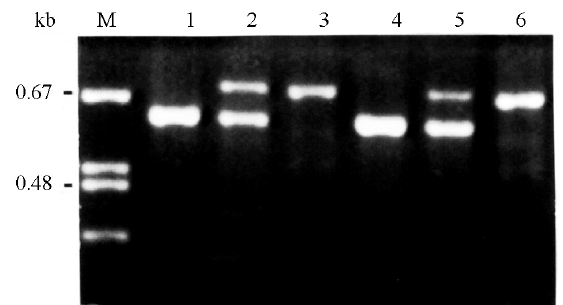
Figure 4 - Gel electrophoresis of the amplified rDNA internal transcribed sequence (ITS) region of the Eucalyptus grandis - Pisolithus tinctorius ectomycorrhizae. (1) P. tinctorius (PT 90A); (2) E. grandis - P. tinctorius (PT 90A) ectomycorrhizae; (3) E. grandis ; (4) P. tinctorius (PT 145); (5) E. grandis – P. tinctorius (PT 145) ectomycorrhizae; (6) E. grandis . Size markers (pUC 19 digested with Hin f I and Rsa I) are indicated by